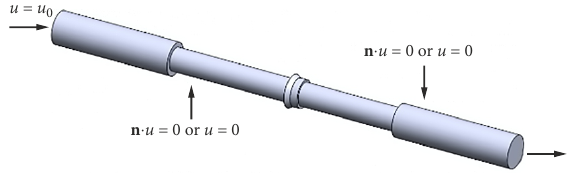
Figure 6. Boundary conditions of the pipeline-fittings system for Ansys  Fluent  simulation